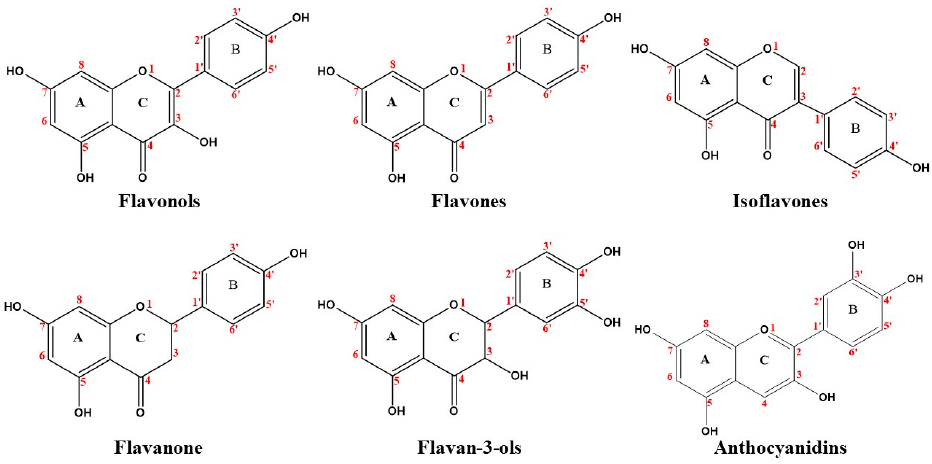
Figure 1. Chemical structure of flavonoids.